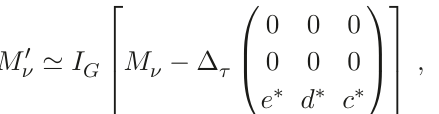
Figure 1 . Changes of I or